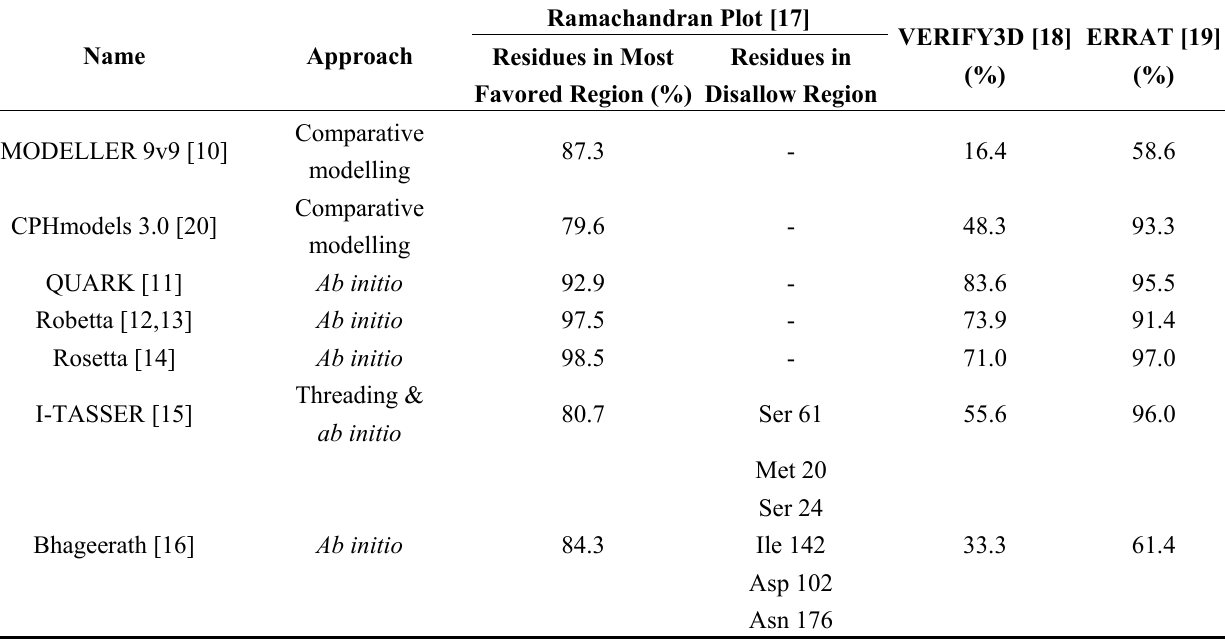
Table 3. Model validation of structures predicted via comparative modeling, threading, ab initio method or combination of the